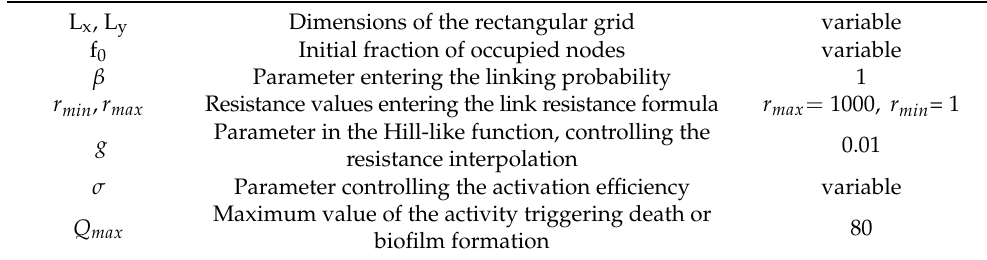
Table 1. Model parameters. We briefly recall their meaning and the values adopted in simulations.